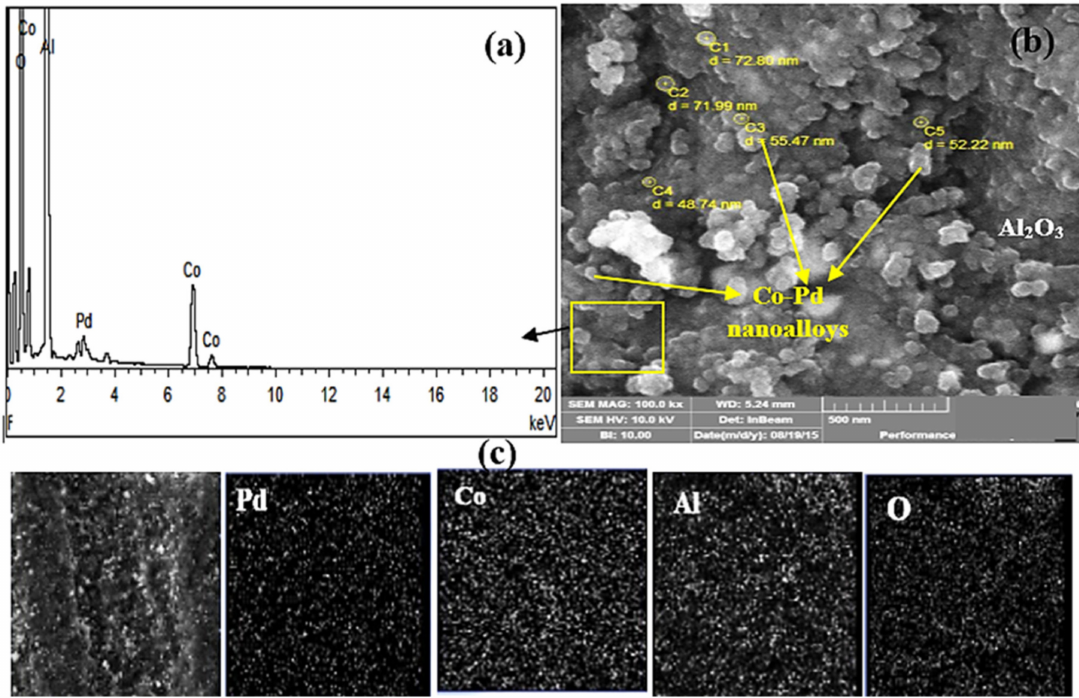
Figure 1. ( a ) EDX profile, ( b ) SEM image, and ( c ) EDX mapping of the synthesized Co–Pd@Al 2 O 3 bimetallic